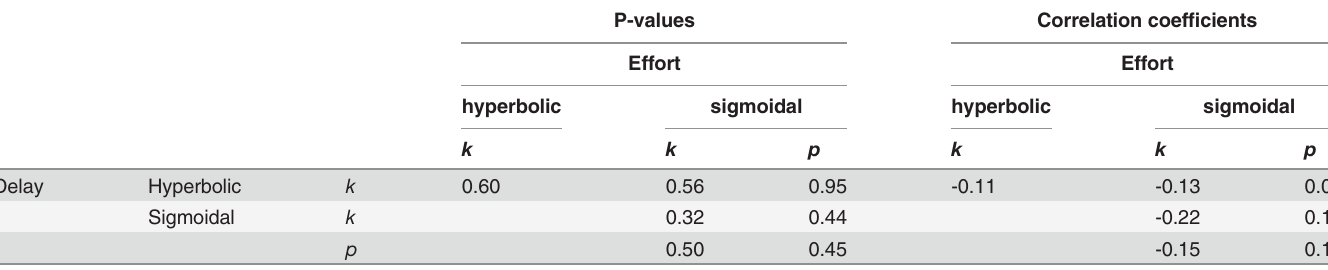
Table 2. No evidence for a relationship between effort and delay discounting.